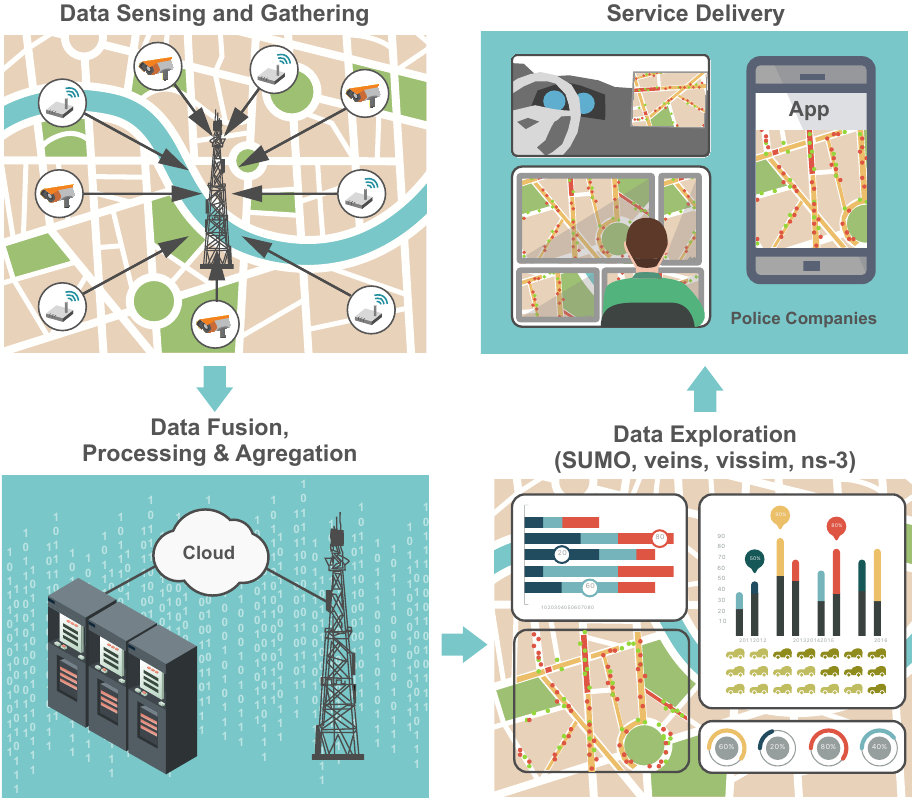
Figure 1. Communications chain of data feeds in smart transportation (parts of the traffic management